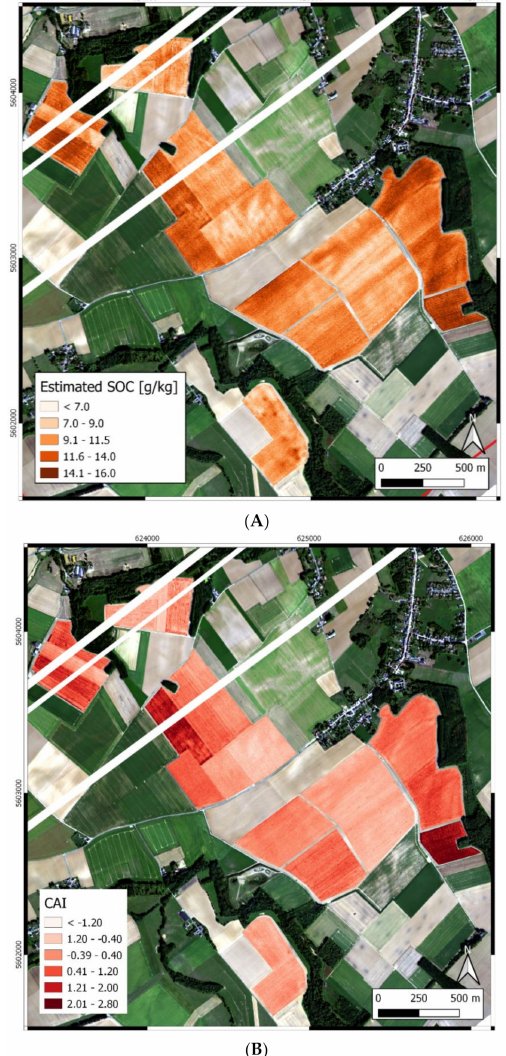
Figure 9. Comparison of the spatial patterns of ( A ) predicted SOC content by a Partial Least Squares Regression (PLSR) model on extracted airborne hyperspectral data and ( B ) the Cellulose Absorption Index (CAI) calculated from extracted airborne hyperspectral data in part of the APEX flight strip. The white stripes were removed because of noise in the airborne